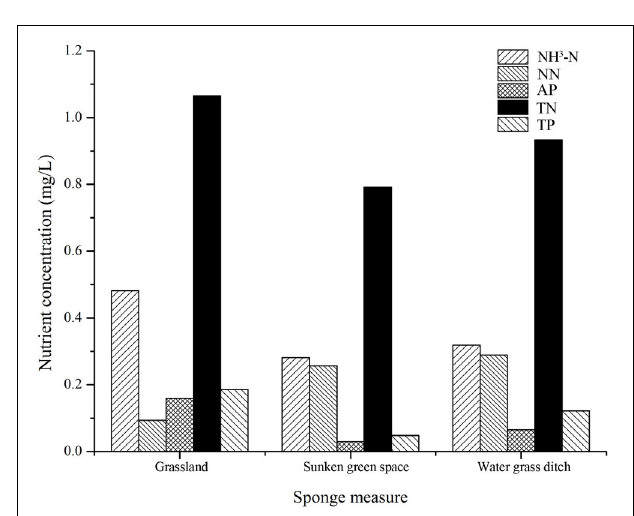
FIGURE 6 | Vertical changes of average soil moisture content under different sponge measures.